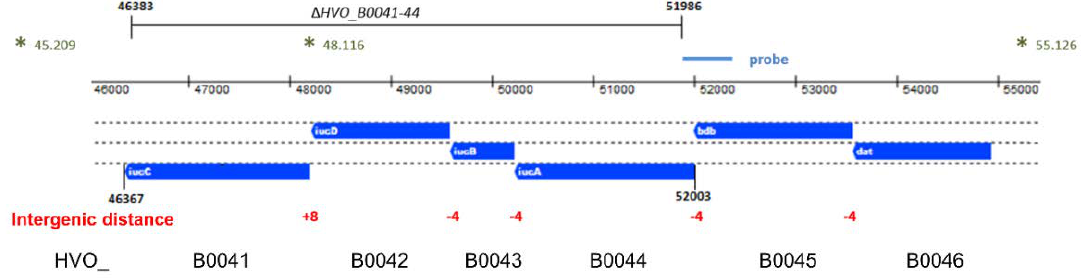
Figure 1. Schematic overview of the genomic region of the iron uptake chelate ( iuc ) gene cluster. The genes are shown in blue below the genomic coordinates. The intergenic distances between the genes are shown in red. The gene names are shown in white within the genes, and the HVO_ designations are shown at the bottom. The region that was deleted in the quadruple deletion mutant is indicated at the top. The asterisks indicate the restriction enzyme sites that were used for the Southern blot analysis; the genomic coordinates of the sites and the position of the probe are also indicated.